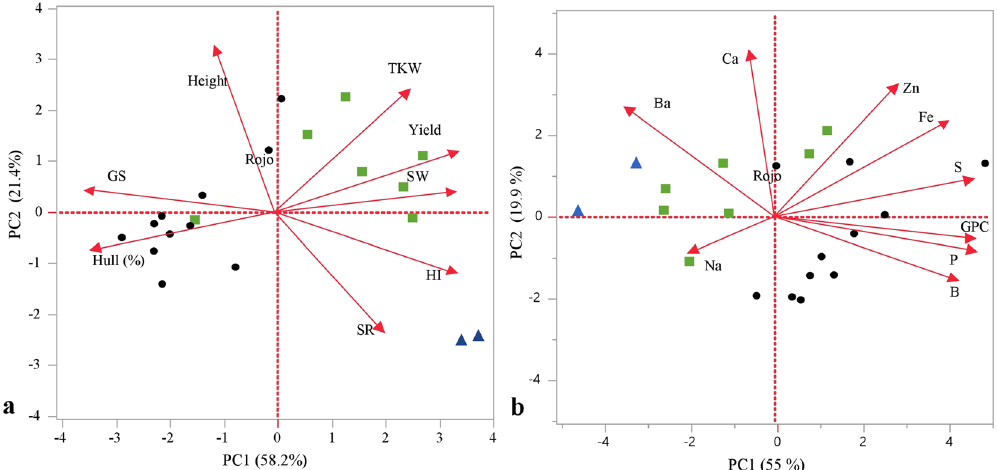
Figure 4. Principal components analysis of agronomic traits and mineral concentration of 20 lines grown under field conditions. Biplot vectors are trait factor loadings for PC1 and PC2. ( a ) Agronomic traits of Stem width (SW), Spike compactness (SC), Grain shape (GS), Thousand-kernel weight (TKW), Hull (%), grain yield (GY), Harvest index (HI) ( b ) Mineral concentration in ppm of Barium (Ba), Boron (B), Calcium (Ca), Iron (Fe), Phosphorus (P), Sodium (Na), Sulphur (S), Zinc (Zn) and Grain protein concentration (GPC). (blue triangle) modern bread wheat (green rectangle) free-threshing spelt (filled cirecle) hulled spelt.